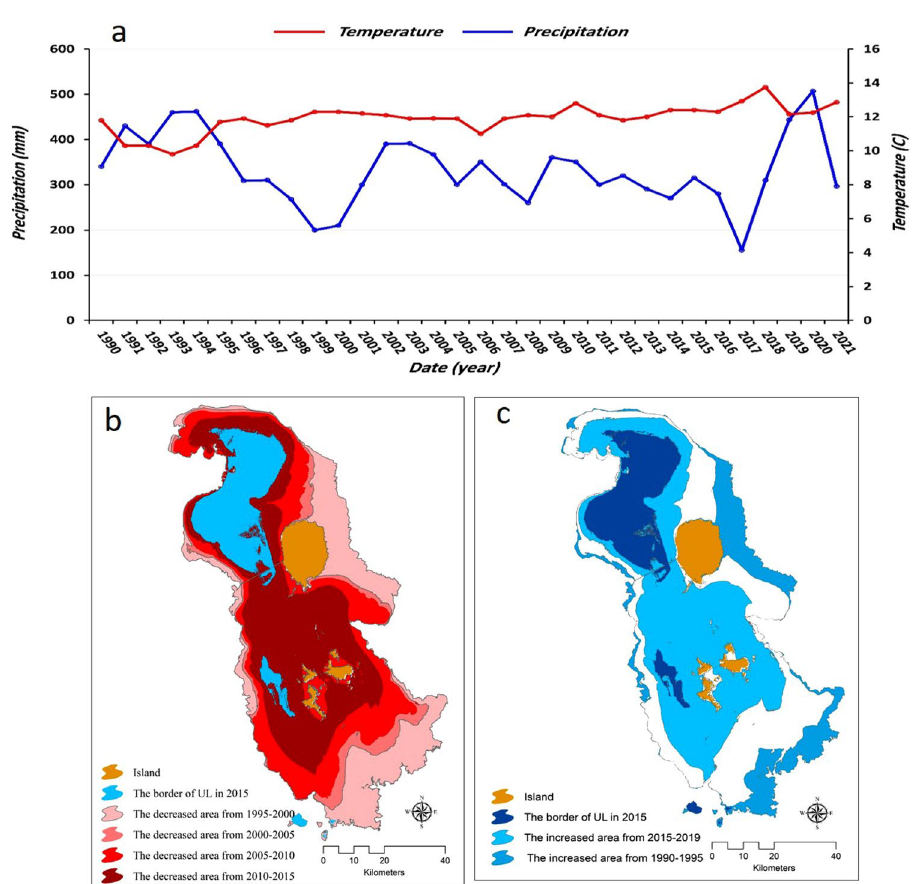
Figure 2. Trend of average annual precipitation and temperature, and the changes in surface area of Lake Urmia between 1990 and 2020. The map is created in ESRI- Arc GIS version 10.7 under licenses of Humboldt- Universität zu Berlin (https:// deskt op. arcgis.